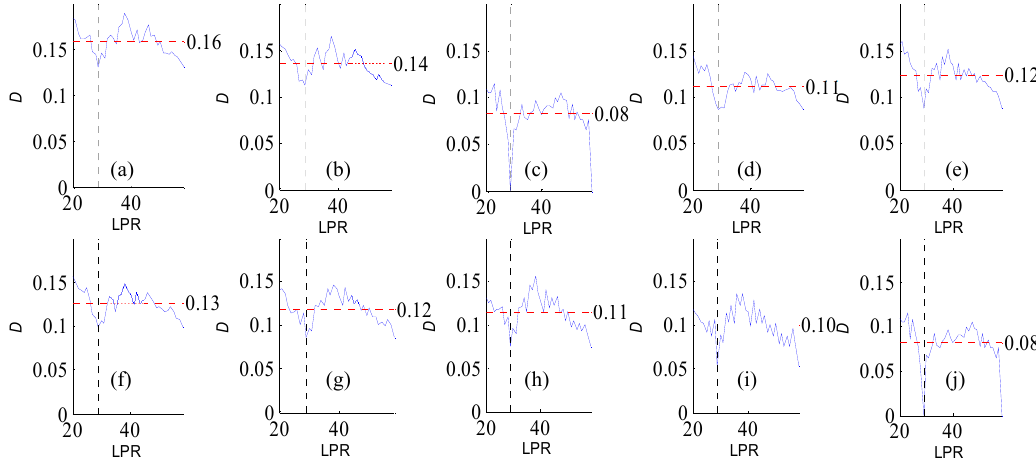
Figure A10. Variation of flow regime alteration degree (D) measured by the RVA with change in the length of post-impact flow time series (LPR) under a periodicity of 29 years. ( a ), ( b ), ( c ), ( d ), ( e ), ( f ), ( g ), ( h ), ( i ), and ( j ) correspond to pre-impact flow time series length = 21, 25, 29, 33, 37, 41, 46, 50, 54, and 58 years, respectively. The abscissa value for the vertical dotted line is 29. The ordinate value for the horizontal dotted line is the mean degree of flow regime alteration in each subfigure.